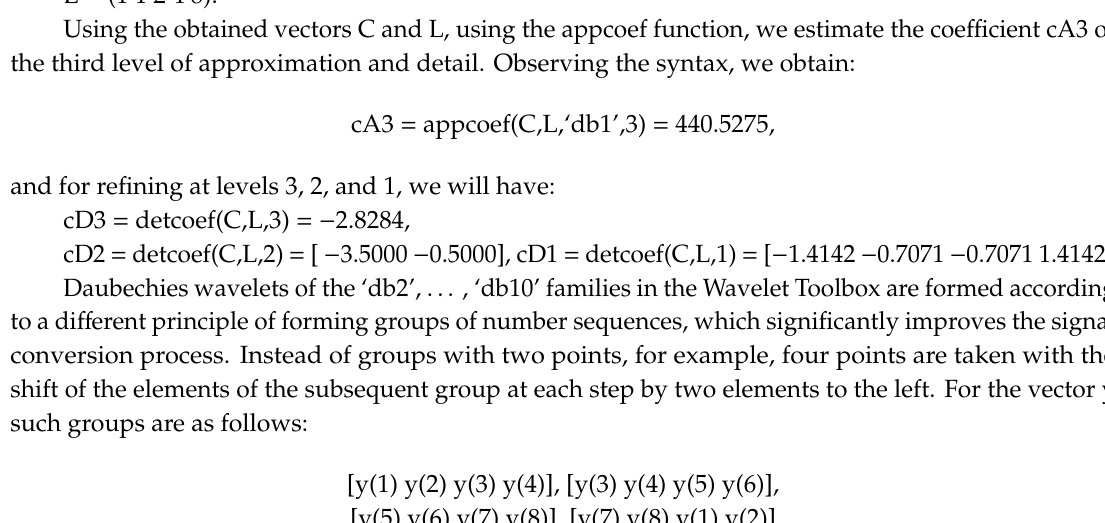
Figure 2. Three-level wavelet decomposition of the vector y based on the ‘db1’ wavelet. [C,L] = wavedec(y,3,‘db1’) C = [440.5275 − 2.8284 − 3.5000 − 0.5000 − 1.4142 − 0.7071 − 0.7071